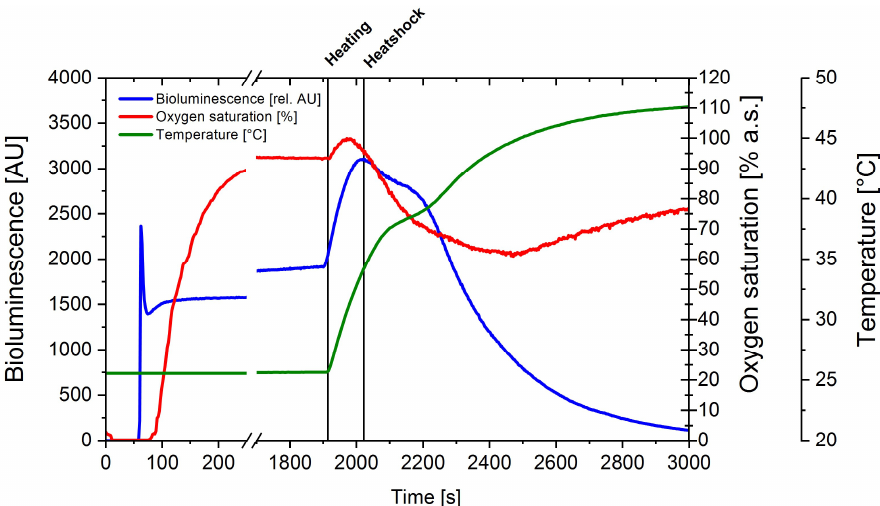
Figure 3. Determination of the influence of temperature on bioluminescence emitted by the cells in a fused-silica cuvette. A cell culture of the reporter strain carrying the yqjF :: luxCDABE fusion, pre-induced by 100mg · L − 1 2,4-DNT, was standardized to an OD 600 = 5. Over the course of the experiment oxygen saturation, temperature and bioluminescence were measured and the cuvette was aerated with molecular oxygen until the saturation reached a constant signal. The cuvette was then heated to 47 °C.